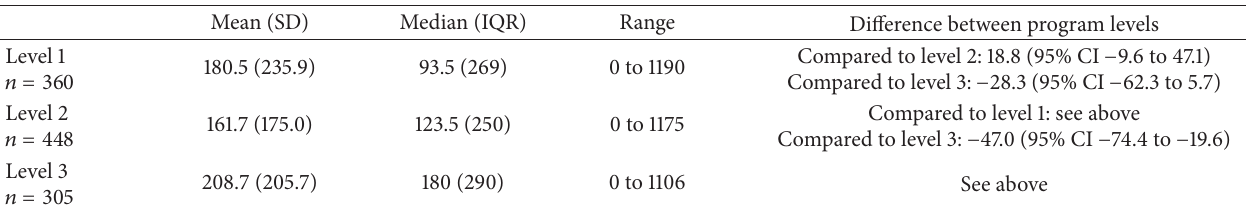
Table 3: Comparison of the amount of exercise repetitions completed in each Weekend Warrior class for program level. Mean (SD) Median (IQR) Range Difference between program levels